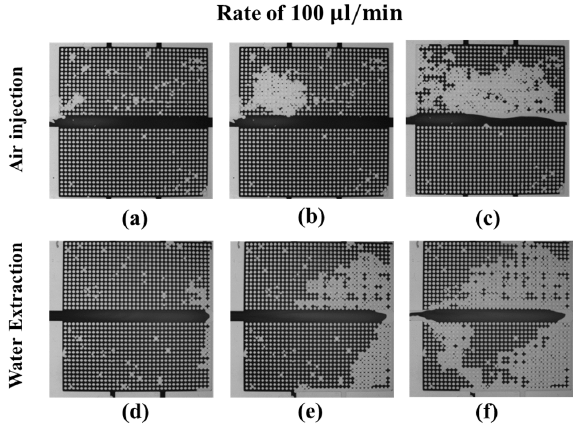
Figure 6. Dynamics of the water (dark)–air (transparent) distributions during the drainage process with an air-injection ( a – c ) and a water-extraction ( d – f ) rate of 100 μ L/min; ( a , d ) correspond to the beginning, ( b , e ) to the middle, and ( c , f ) to the end of the drainage process.